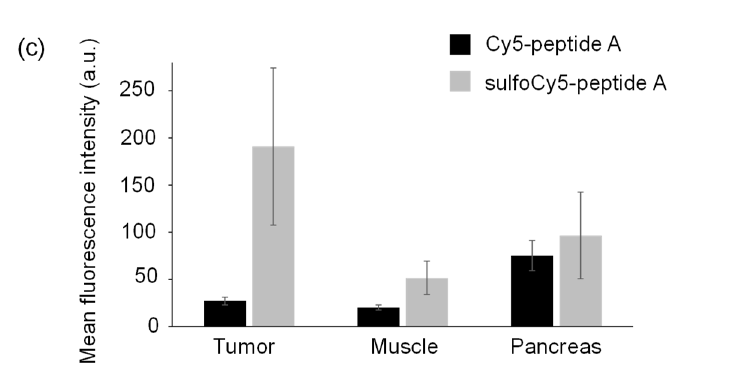
Figure 6. Ex vivo fluorescence imaging of organs collected from tumor-bearing mice injected with dye-peptide A. He, heart; Lu, lung; Li, liver; Pa, pancreas; Sp, spleen; St, stomach; In, intestine; Br, brain; Ki, kidney; Mu, muscle; Tu, tumor; Ur, urine; Bl, blood. Comparison of ( a ) all organs, urine, and blood, and ( b ) tumors, muscle, and pancreases. ( c ) The comparison of the mean fluorescence intensity of tumors, muscle and pancreases. The data represent the mean ± SEM ( n = 3).